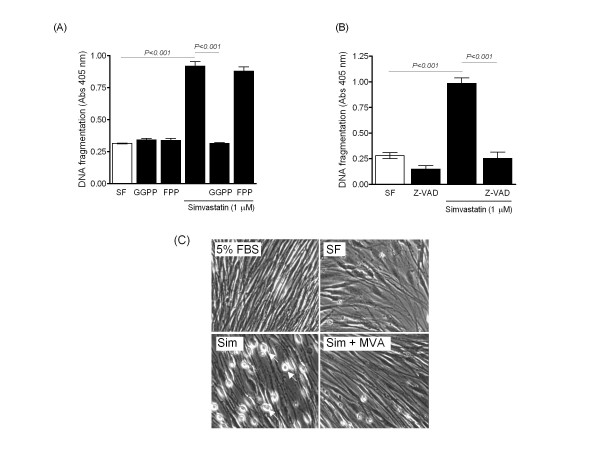
Effect of simvastatin on DNA fragmentation and PASMC morphology. (A-B) Pro-apoptotic effect of simvastatin reversed by geranylgeranylpyrophosphate (GGPP, 10 μM) and the pan-caspase inhibitor Z-VAD-fmk (Z-VAD, 10 μM), but not by farnesylpyrophosphate (FPP, 10 μM). (C) PASMCs showed characteristic morphological changes (arrows) following simvastatin-treatment (Sim, 1 μM), which were prevented by co-administration of mevalonate (MVA, 100 μM). Data are mean ± SEM of replicate values (n = 4) and representative of independent experiments with non-IPAH (A) and IPAH cell isolates (B). SF = serum free untreated cells.